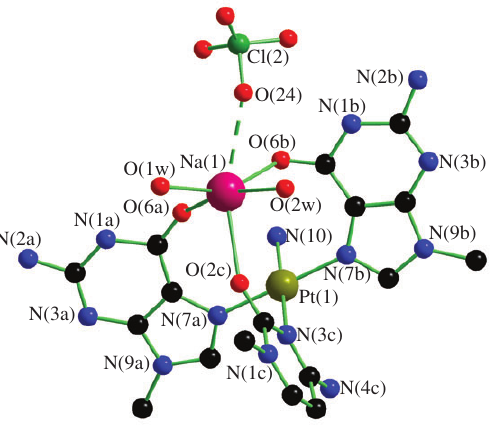
Figure 9 Structure of [Pt(NH (Freisinger et al.,